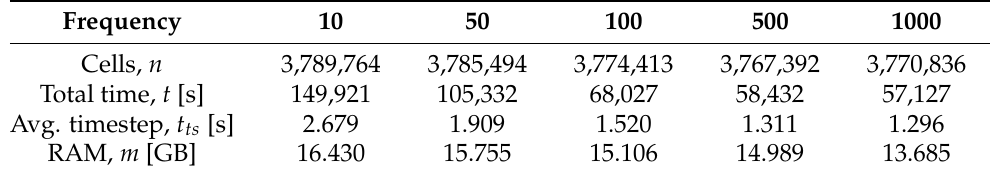
Table A12. Influence of the refinement frequency on the computational time. Setup is identical to Table A7 with load balancing enabled and performed when the imbalance reaches 20%.